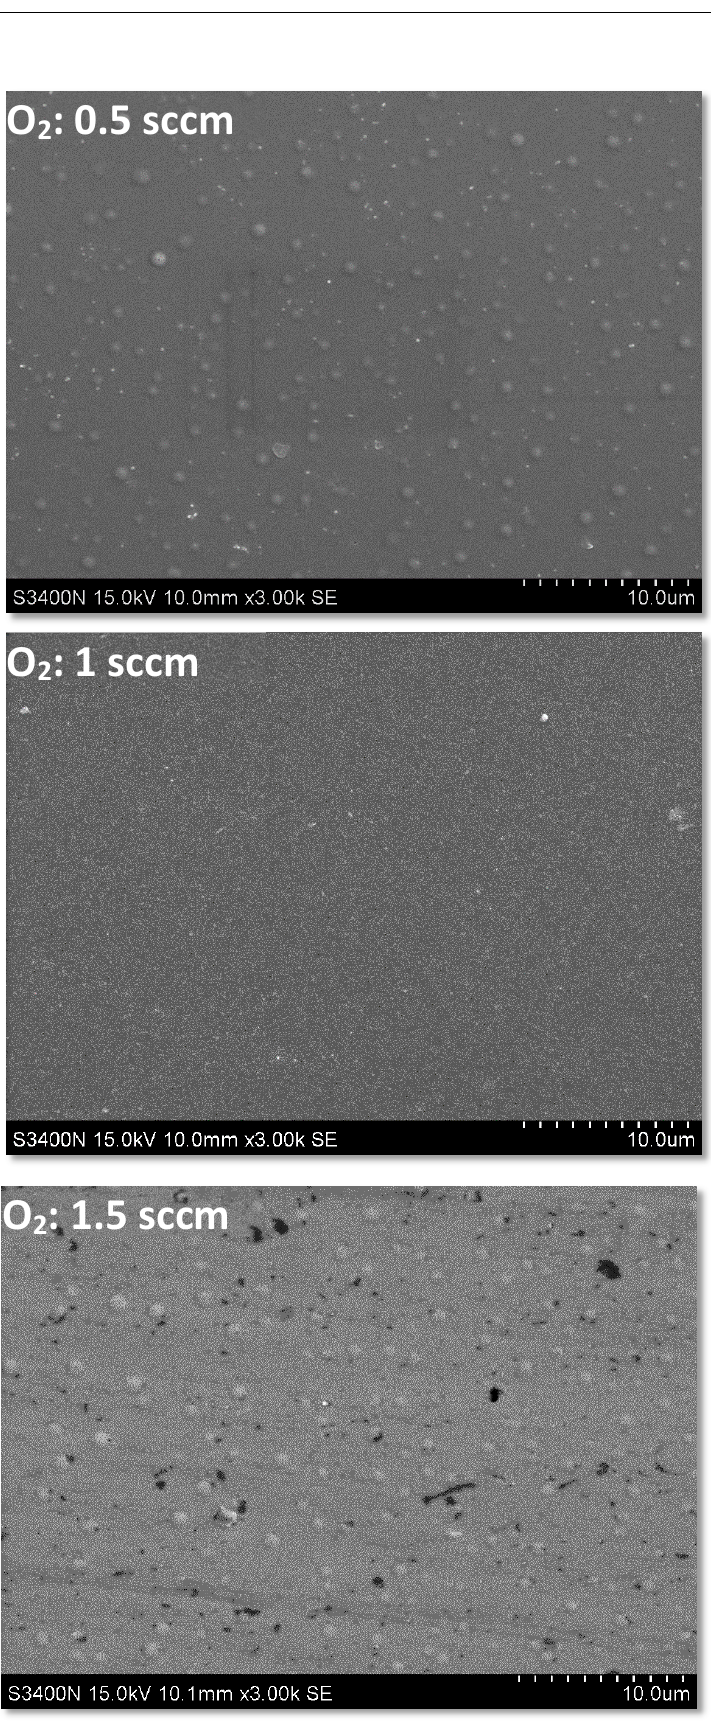
Figure A1. Selected SEM images of annealed films under different oxygen flow rates.